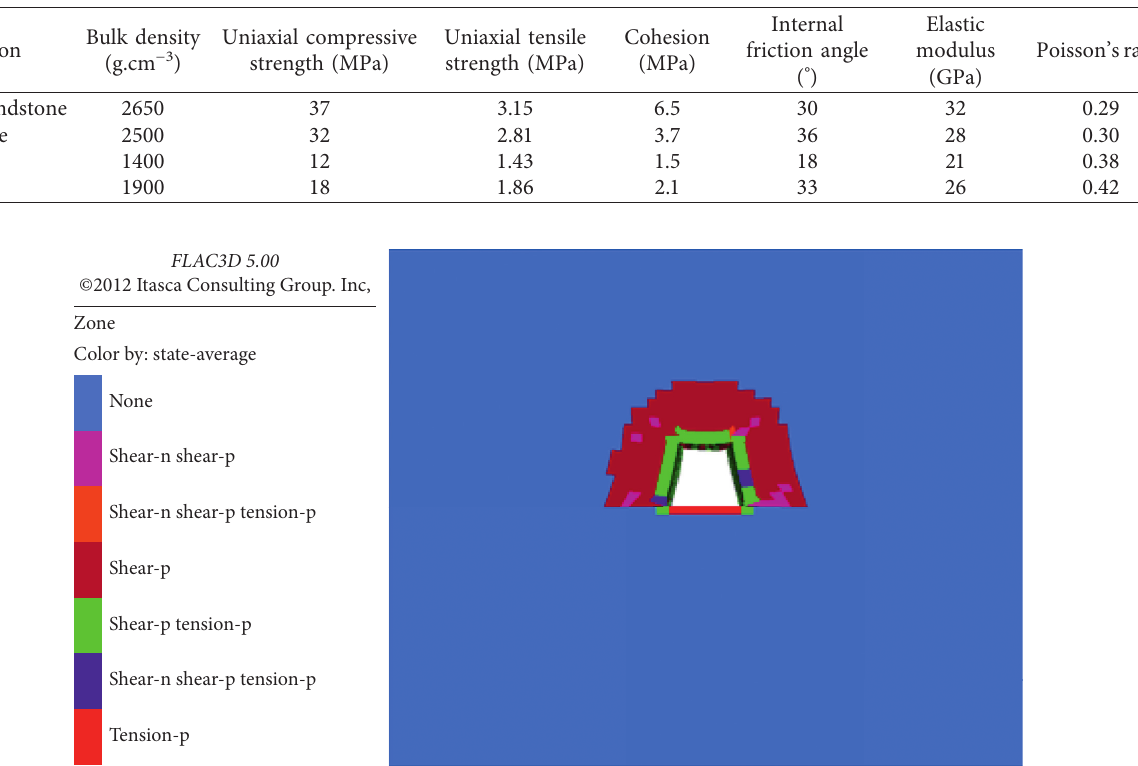
Table 2: Numerical calculation parameters.